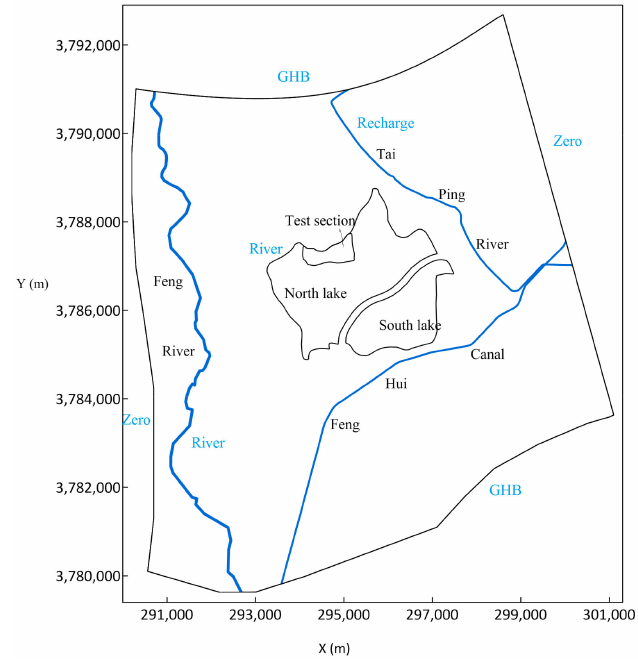
Figure 6. Boundary range and